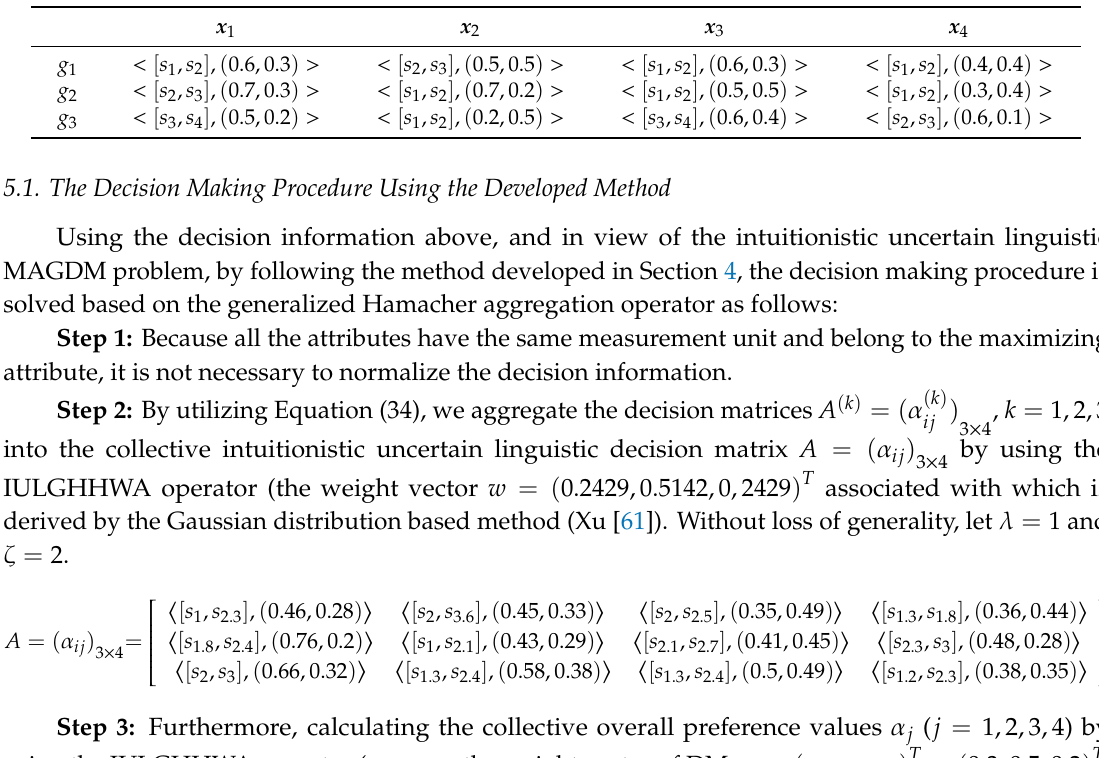
Table 3. Decision matrix A ( 3 ) with